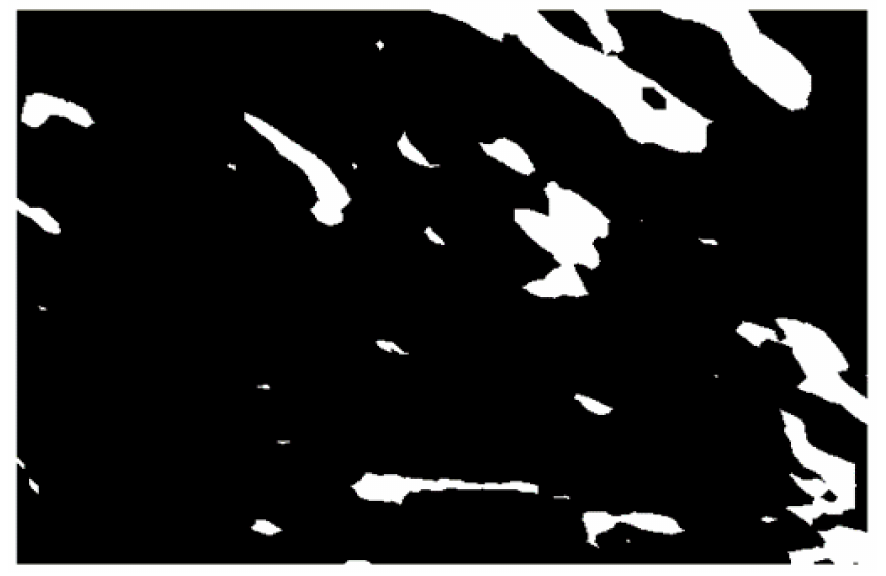
Figure 3. Extracted gust regions in black-white scale from the wind field in Figure 2. The gust regions are in